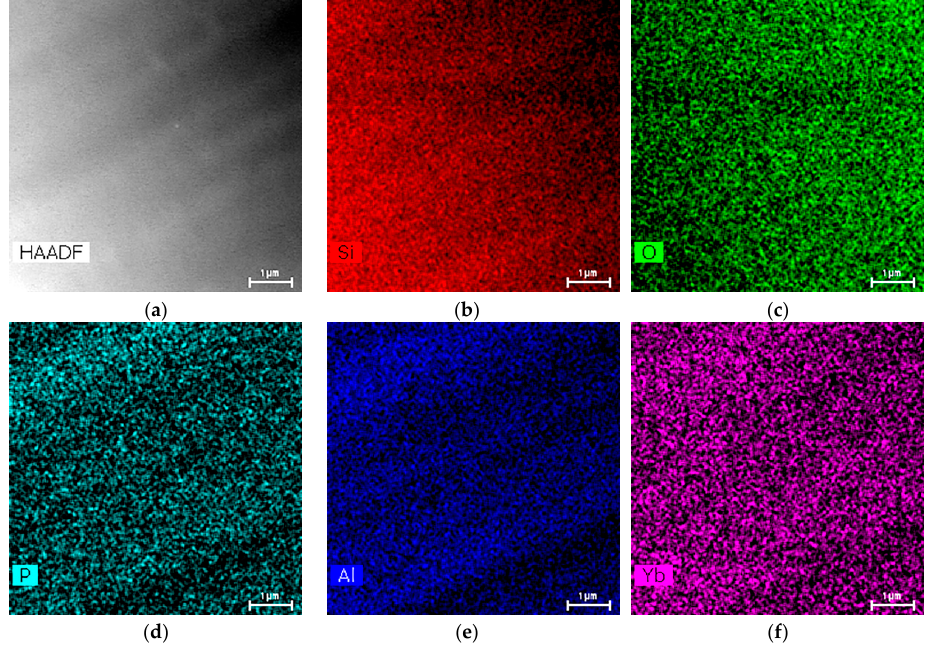
Figure 9. STEM micrograph showing the nanostructure and elemental distribution a doped fiber core produced by granulated silica derived from the sol-gel process [8]. ( a ): HAADF image; Chemical mapping of ( b ): Silicon; ( c ): Oxygen; ( d ): Phosphorous; ( e ): Aluminum; ( f ): Ytterbium.